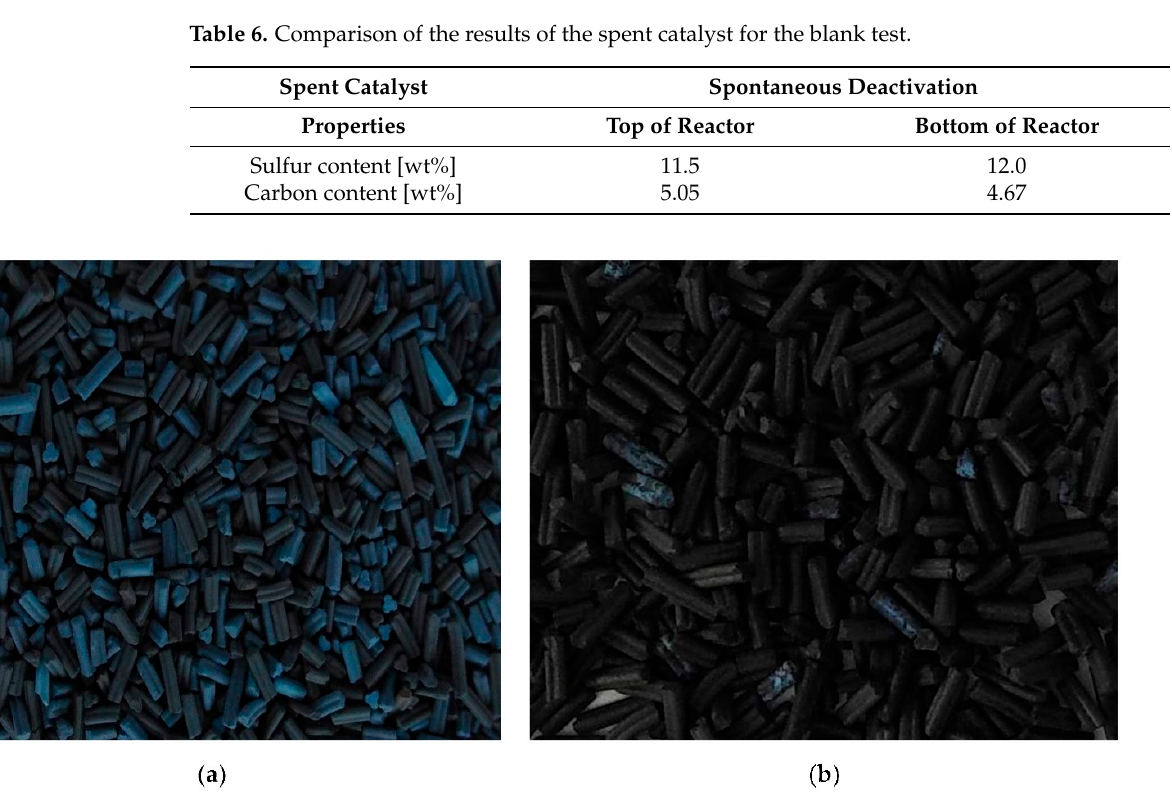
Figure 19. ( a ) Photo of fresh catalyst. ( b ) Photo of spent catalyst. Table 5. Comparison of the results of the spent catalyst.